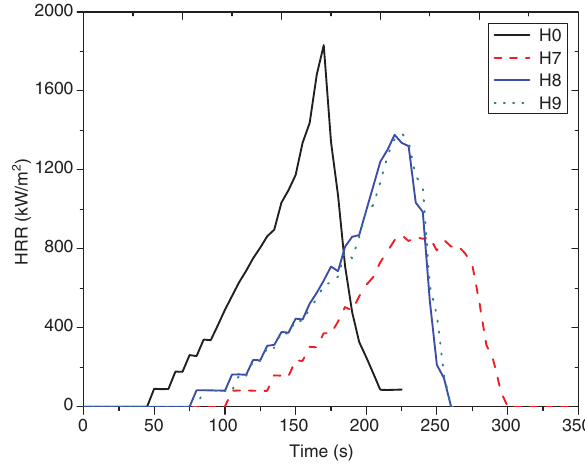
Figure 8: Heat release rate curves of neat PP and the PP/Cu-LDH nanocomposites.